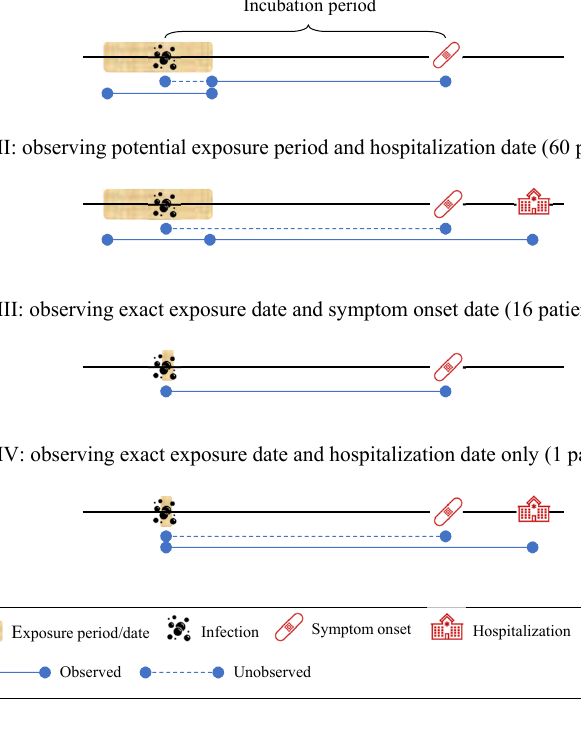
Figure 2. The four types of observations available for the data analysis. The total number of patients is